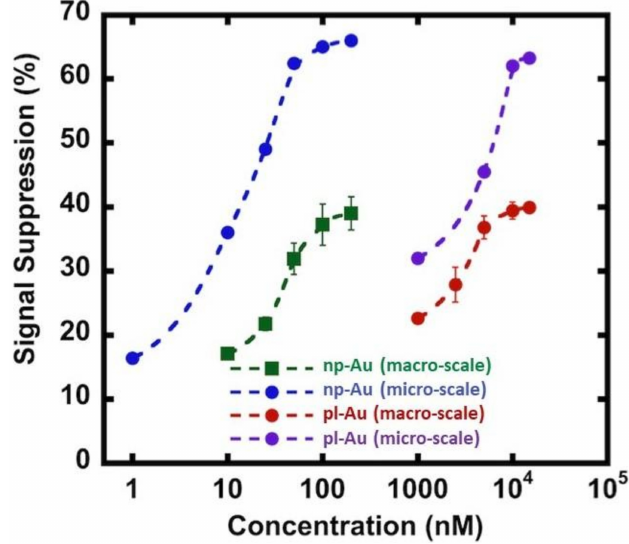
Figure 4. Comparison of DNA hybridization efficiency between macro-scale and micro-scale electrode configurations for np-Au and pl-Au electrodes. Signal suppression (%) is defined as (( I probe − I target )/ I probe ) × 100, where I probe and I target are SWV current signals measured for probe DNA alone and upon target capture, respectively. Raw data are included in Figures A5 and